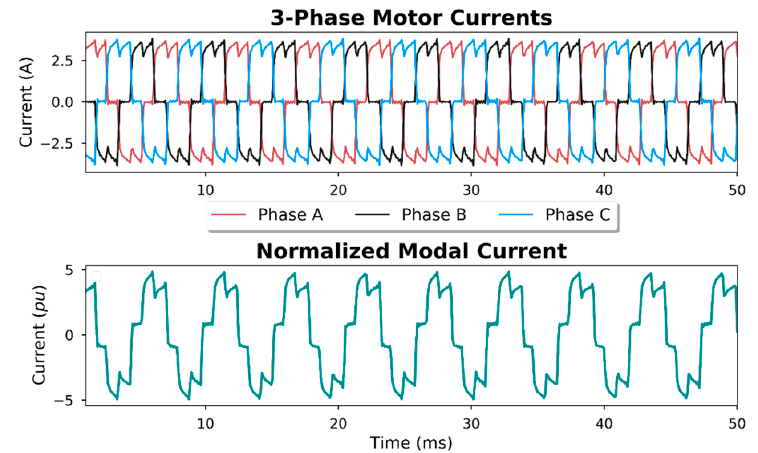
Figure 8. Modal current computation from the three-phase motor current.